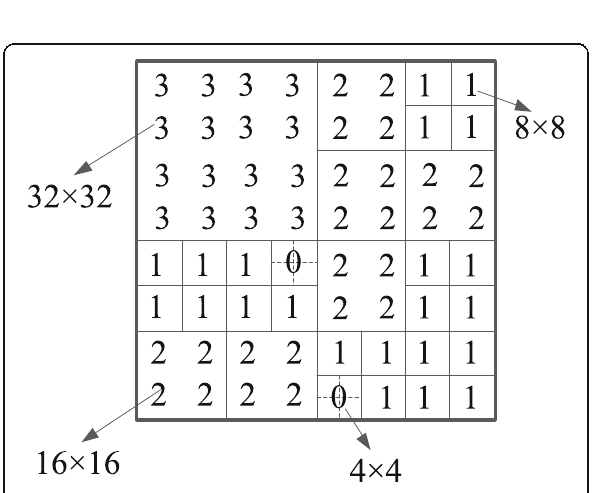
types are marked. Table 1 shows the label for the TU partition types. Figure 3 shows an example of marking TU partition types with their labels in a 64 × 64 CU. Thirdly, we count up the histogram of TU partition type. The number of each TU partition type in the first I/P frame of each GOP is counted, denoted by F i = { f i f GOPs in the video sequence, and the value of the second index of f is the same as the label shown in Table 1. Each F the five TU partition types in the i -th GOP. The average value of F i is calculated as: